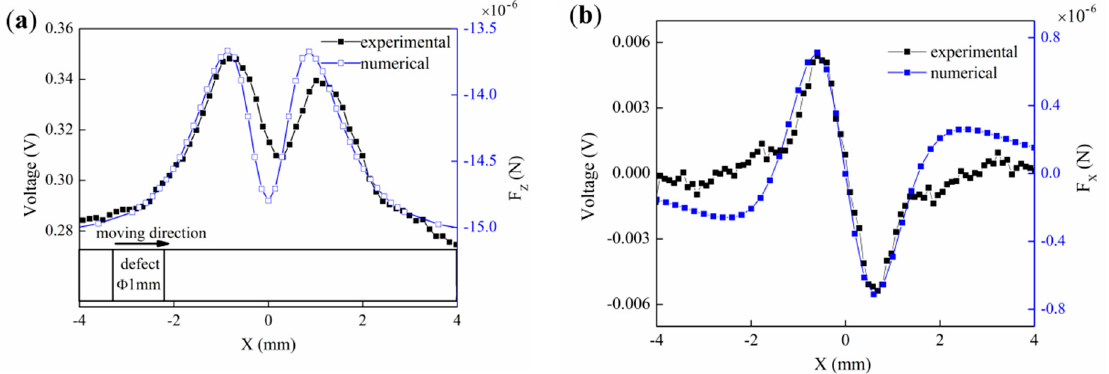
Figure 5. Experimental and numerical simulation results show that the detection quantities of the z-component and the x-component, the defect is a circular through hole with a diameter of 1 mm. ( a ) z-component and ( b ) x-component.